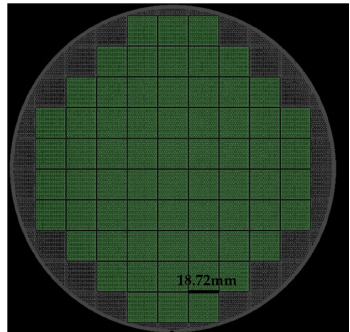
Figure 6. Partial array of wafers with pads, bumps and daisy chains.